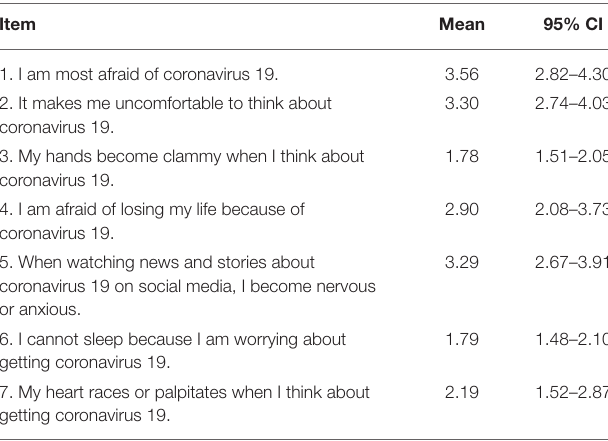
TABLE 2 | Pooled mean of fear of COVID-19 scale by